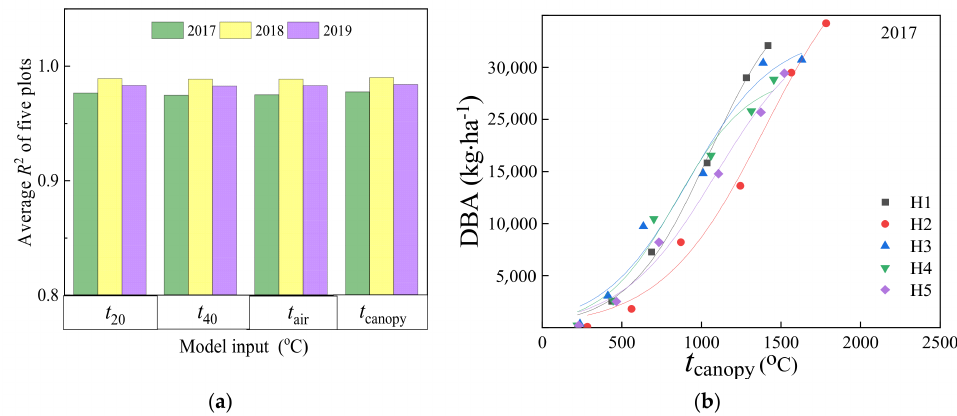
Figure 8. The performance of the DBA simulation results based on the logistic models. ( a ) Average values of R 2 of DBA simulating at five plots based on the logistic model with four kinds of effective accumulated temperature in 2017, 2018, and 2019; ( b ) DBA simulating in five plots based on the logistic model with effective accumulated canopy temperature ( t canopy ) in 2017.